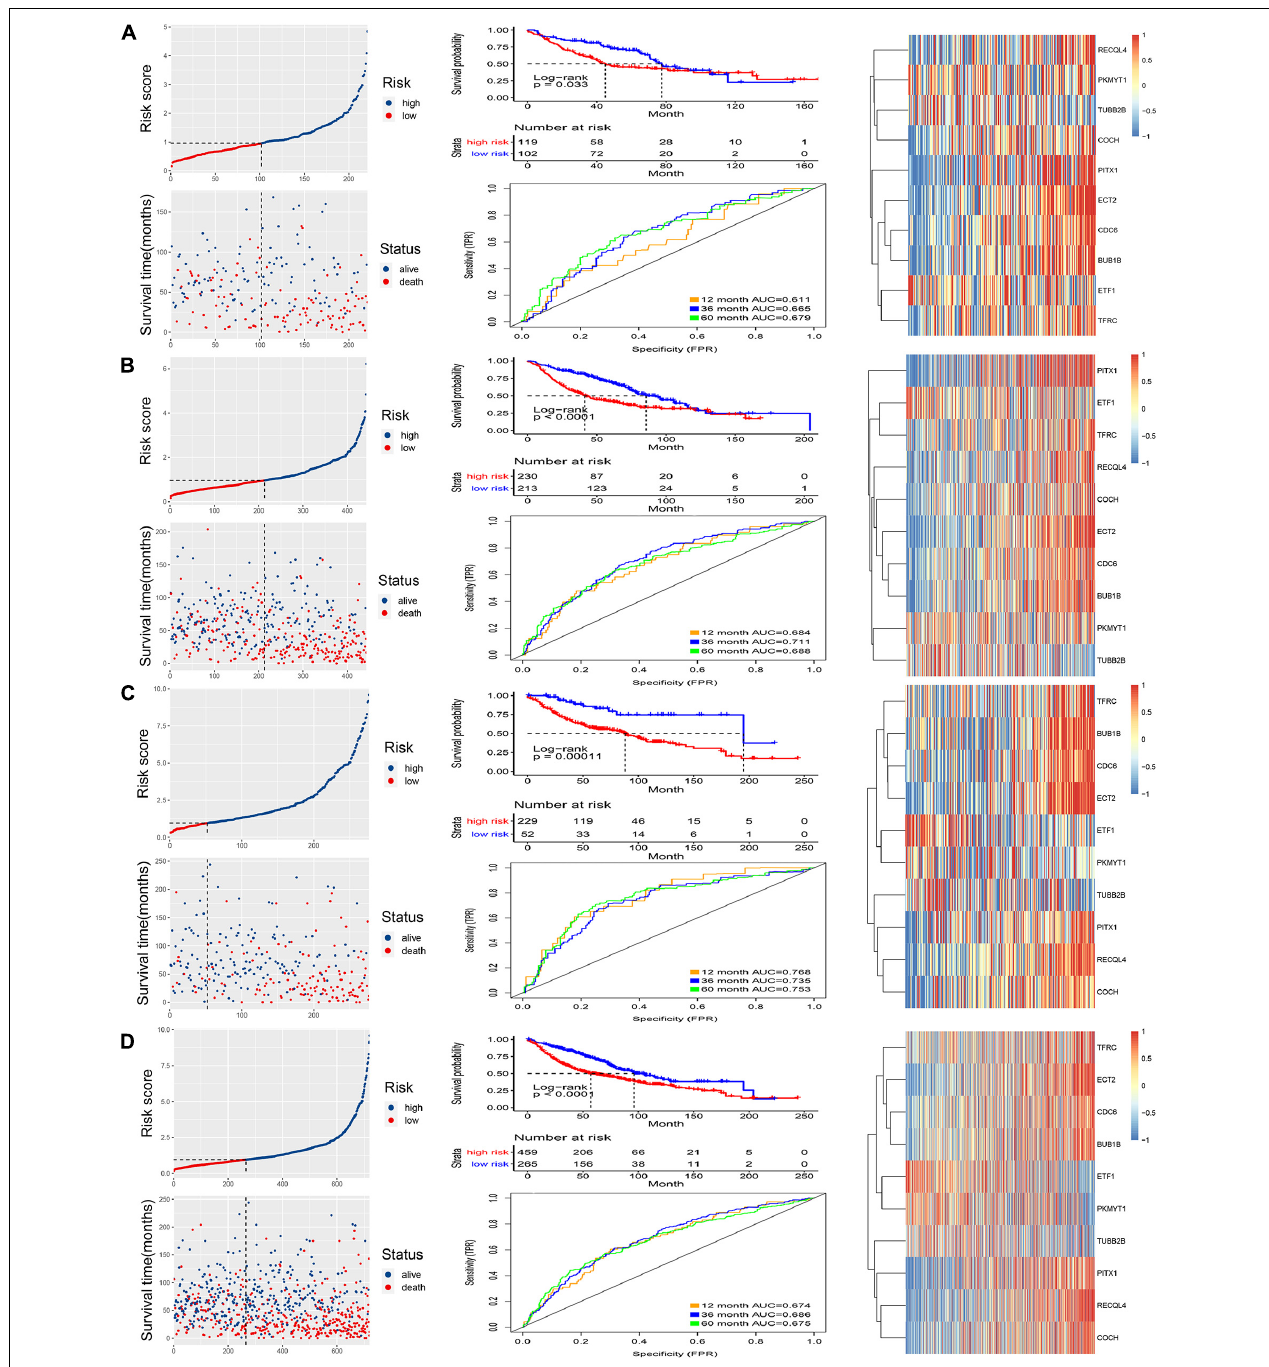
FIGURE 3 | Validation of the signature. Risk score and survival analysis of the high and low groups, heatmap of the expression of 10 CCRGs, and the AUC of the ROC in (A) internal test group, (B) internal group, (C) external test group and (D) all